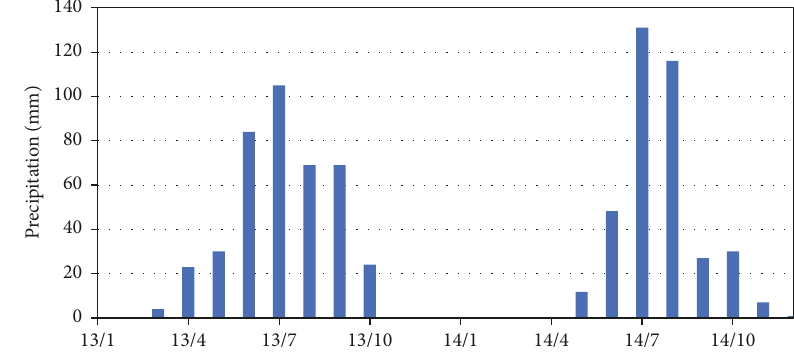
Figure 8: The monthly average precipitation amount from Jan. to Oct. in 2013 and 2014.